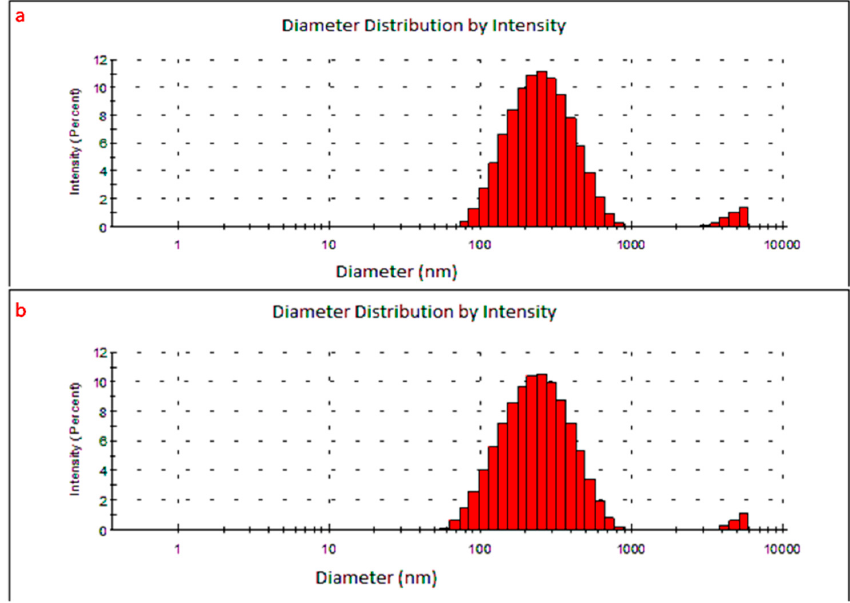
Figure 7. Histograms of the diameter distribution for PS liposomes without encapsulated extract of Stellaria media (L.) Vill. ( a ) and PSE liposomes with encapsulated extract of Stellaria media (L.) Vill. ( b ). Concerning the surface electric charge (Zeta potential), negative values were ob- tained for the PS (-2.96mV) and PSE (-1.93mV) formulations, while for the PC and PCE ones, the values were positive (+2.01 mV and + 3.28 mV, respectively). 3.5. Encapsulation Efficiency of Stellaria Media (L.) Vill. Extract. The encapsulation efficiency of Stellaria media (L.) Vill. extract in liposomes (PCE and PSE formulations) was evaluated and a 92.09% inclusion of Stellaria media (L.) Vill. extract was obtained for PCE liposomes compared to 84.25% in the case of PSE liposomes. 4. Discussion Figure 2 shows the results of the macroscopic analysis, highlighting the main char- acteristics of the plant Stellaria media (L.) Vill. in the family Caryophyllaceae , genus Stellaria . The aerial part of the plant and the characteristics of the family it belongs to can be seen in Figure 2a—the leaves are sessile having an opposite orientation on the stem and the stem is articulated. In Figure 2b, the characteristics of the flower can be observed: five petals oriented in the shape of a star (hence the name Stellaria ) and five sepals covered by protector hairs. Macroscopic analysis from Figures 2a,b demonstrated that the plant Stellaria media (L.) Vill. belongs to the family Caryophyllaceae . The genus Stellaria includes several plants ( Stellaria alsine , Stellaria graminea , Stellaria nemorum , Stellaria pallida , Stellaria langifolia , etc.) and the plant Stellaria media (L.) Vill. differs from the others by the existence of a single series of protector hairs on the stem [26]. Through microscopic analysis, it was possible to demonstrate the existence of these protector hairs and that the harvested plant is indeed Stellaria media (L.) Vill. Figure 2c shows the cross-section through the stem and Figure 2d, the longitudinal section of the stem, both highlighting the existing protector hairs. According to the literature, Stellaria media (L.) Vill. is characterized by a highly complex chemical composition consisting of polyphenols, saponosides and vitamin C, which, together, the strong antioxidant activity of this plant is attributed to [26,27]. Phe-